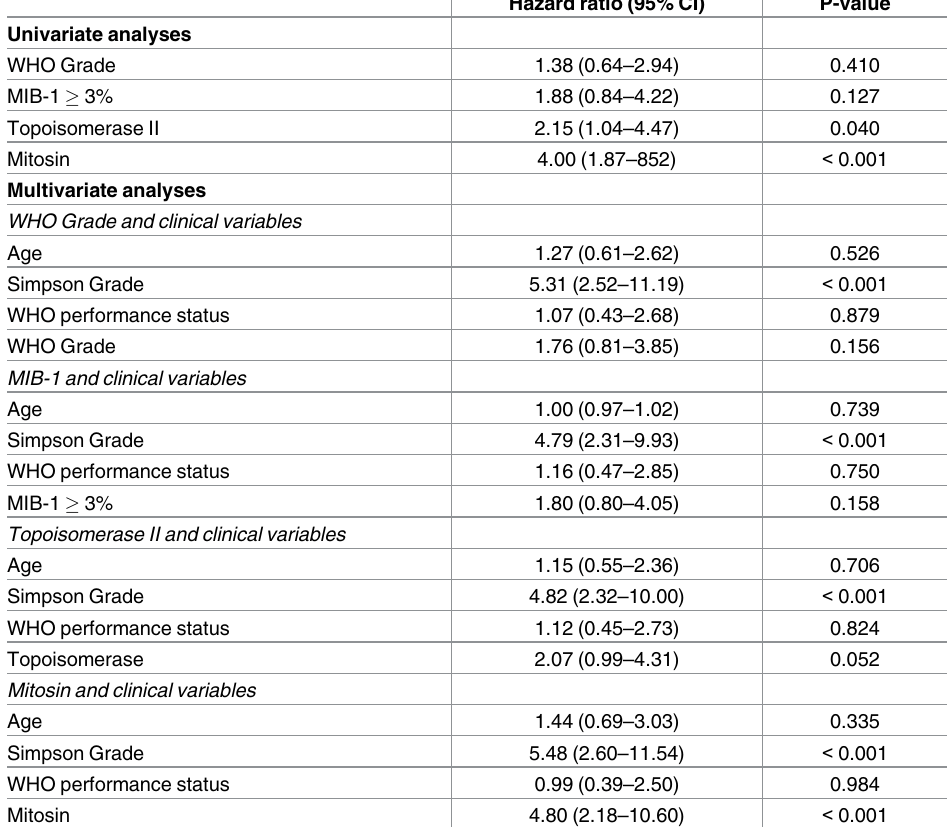
Table 4. Cox hazard univariate and multivariate survival analysesof proliferation assessment meth- ods for recurrence-free